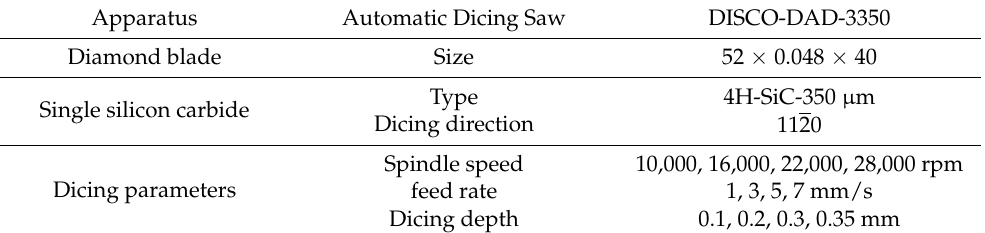
Table 2. Dicing test conditions.